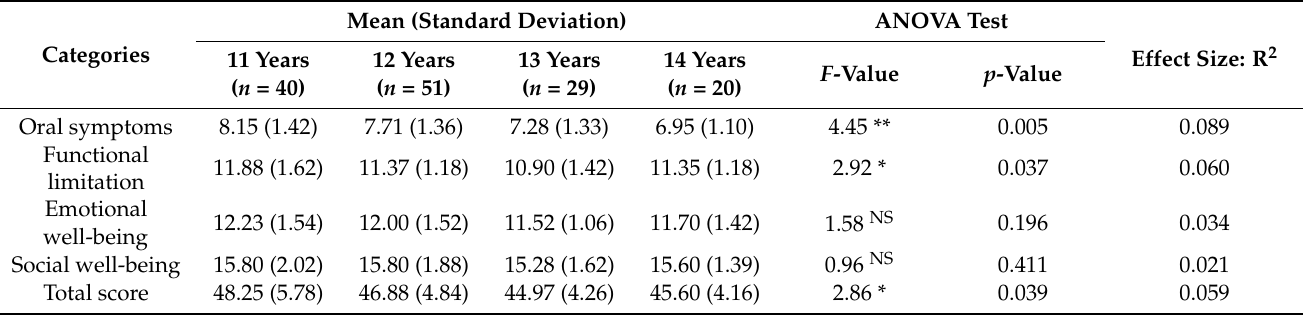
Table 3. Inferential analysis. Variables of the CPQ-Esp 11–14 questionnaire on OHRQoL according to age ( n = 140).